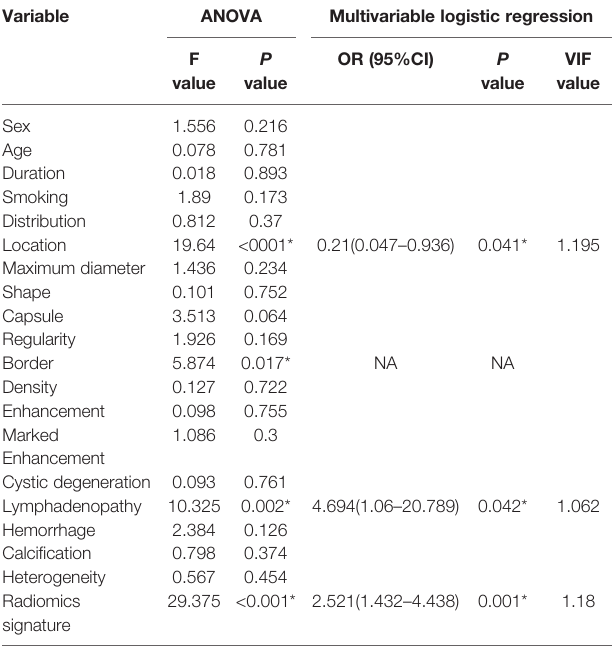
TABLE 4 | Multivariable logistic regression analysis for selecting predictors for model construction. Variable